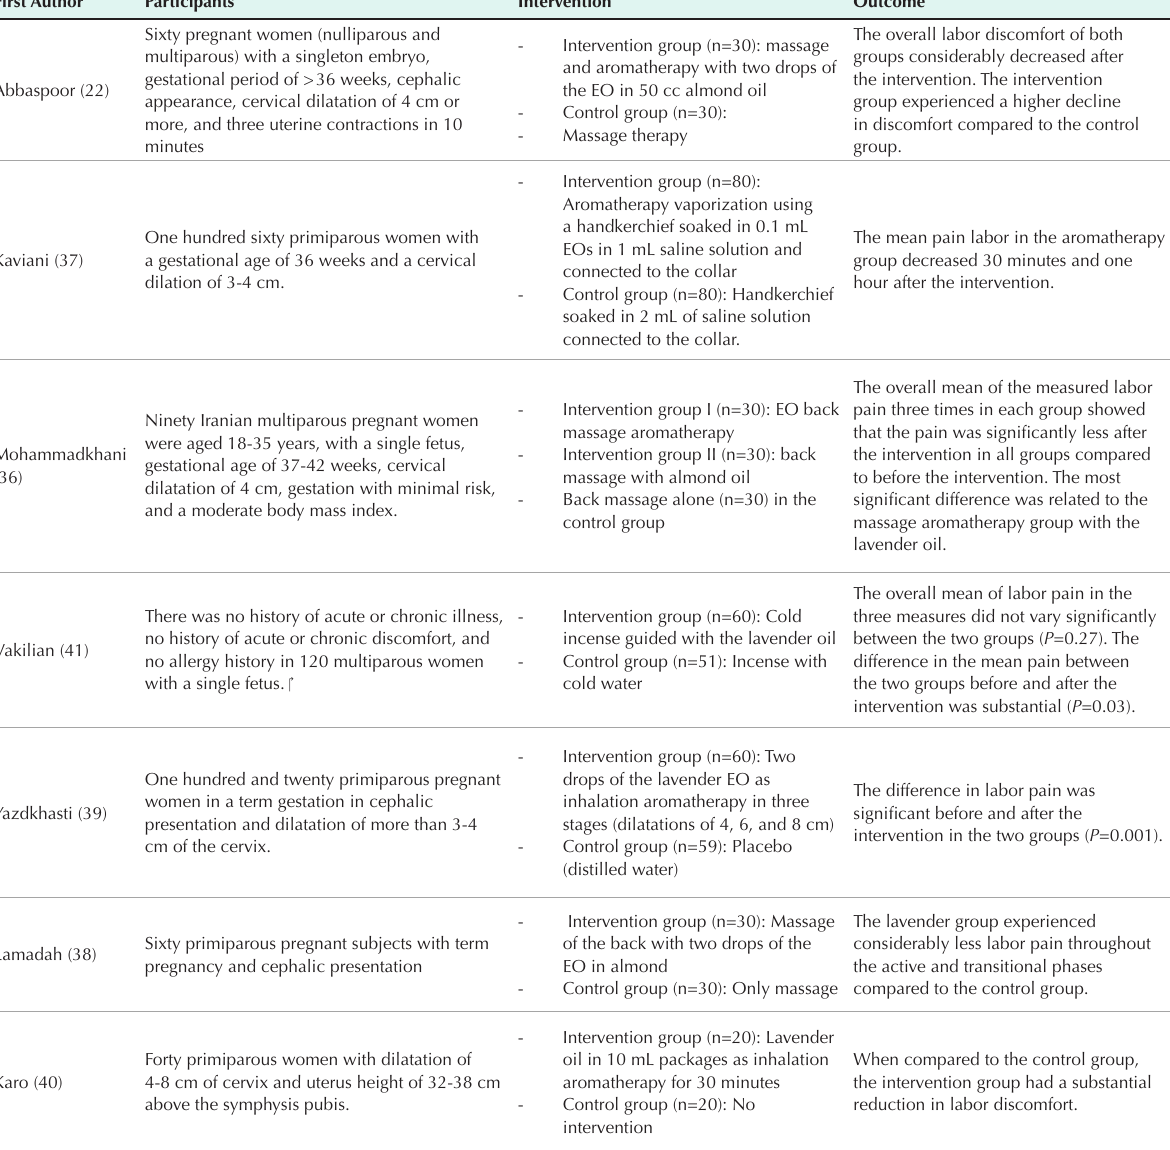
Table 1. Characteristics of the Final Reviewed Studies in the Present